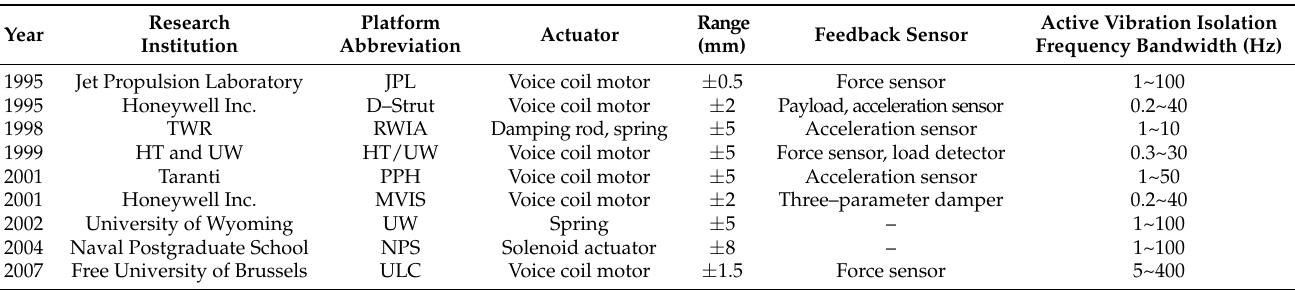
Table 3. Typical flexible Stewart